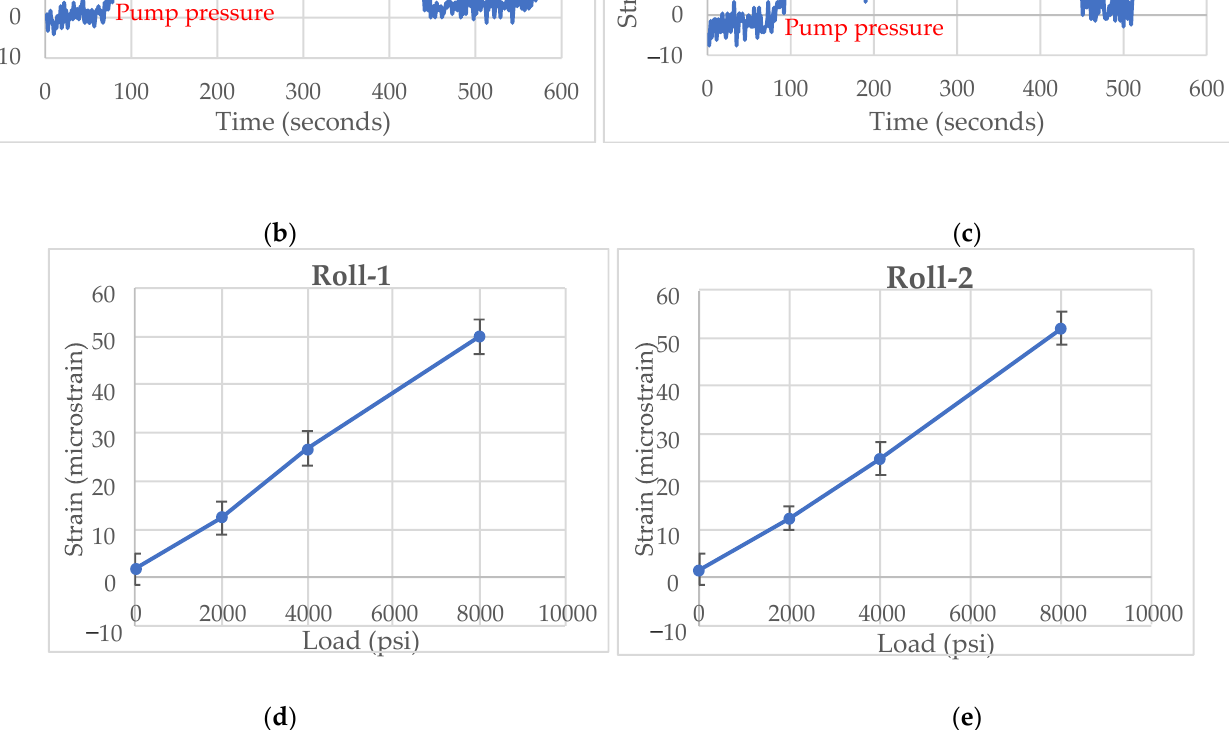
Figure 12. ( a ) Hydraulic jacks placed on Roll-1 and Roll-2. ( b ) Strain measured by Roll-1 for varying loads. ( c ) Strain measured by Roll-2 for varying load. ( d ) Strain vs. load (psi) on Roll-1. ( e ) Strain vs. load (psi) on Roll-2.